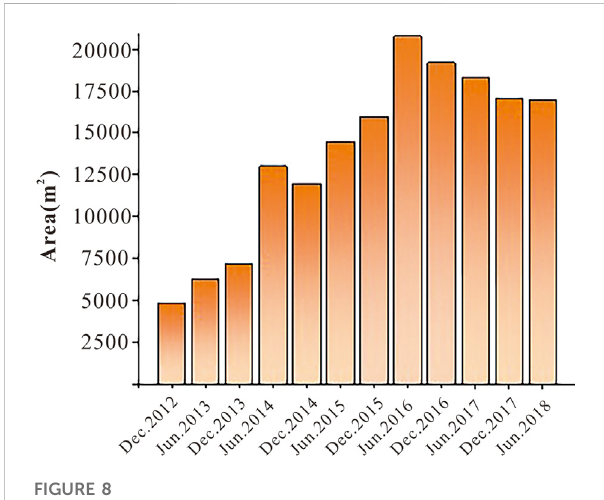
FIGURE 8 Area of horizontal displacement strong deformation